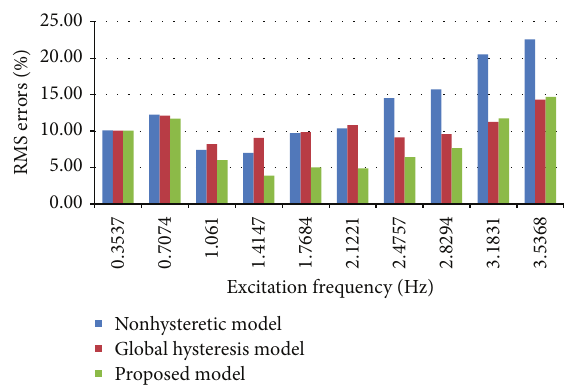
Figure 8: Relative RMS errors in various exciting frequencies with amplitude of 45